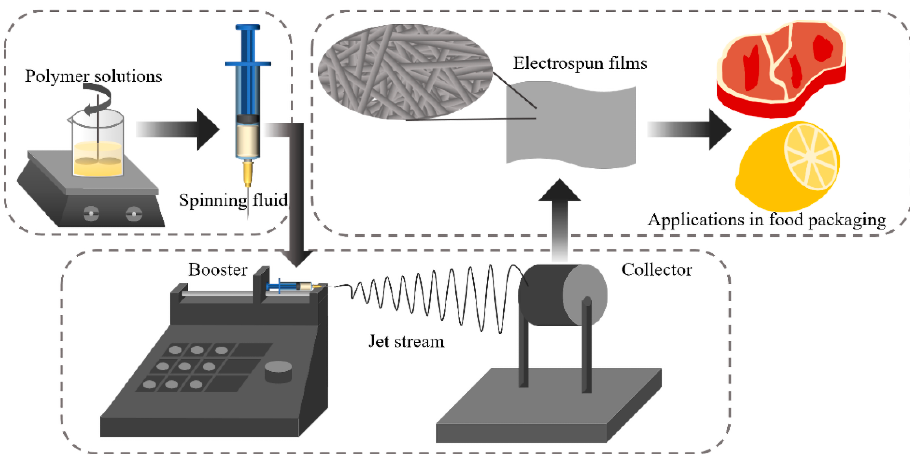
Figure 2. Schematic diagram of the electrospinning equipment.